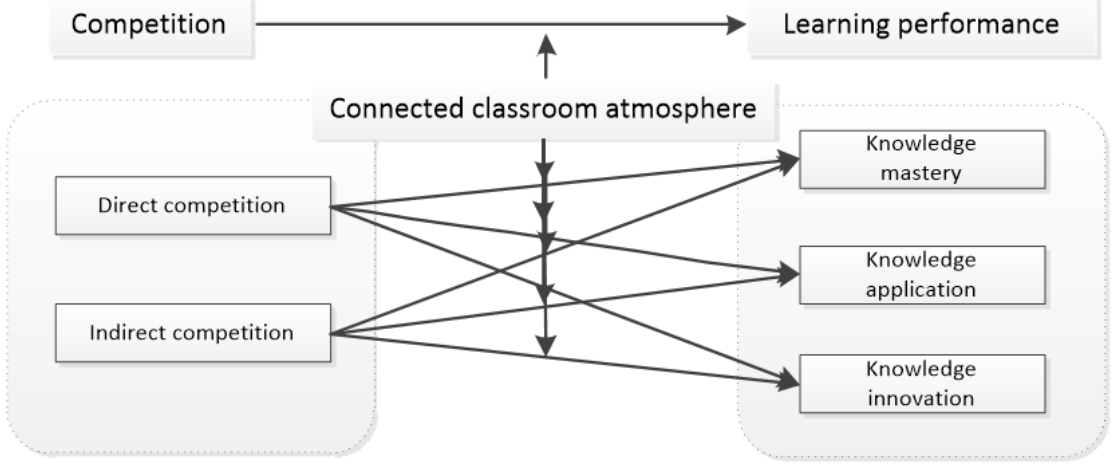
Figure 3. Modulation effect model of a connected classroom atmosphere.